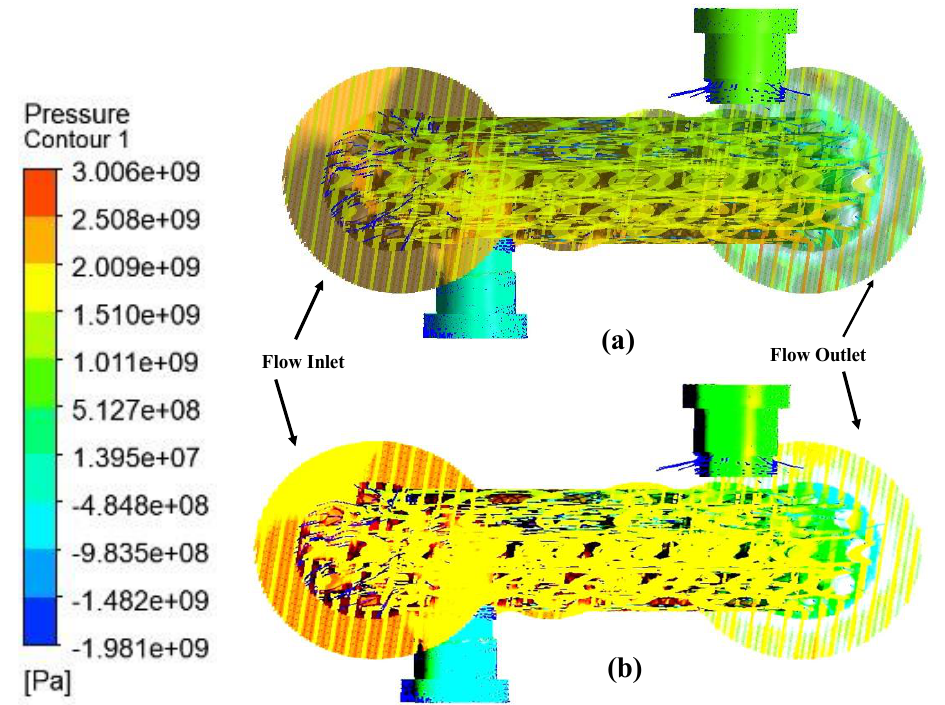
Figure 7. Pressure contours of ( a ) round tubes and ( b ) hexagonal tubes of a heat exchanger.